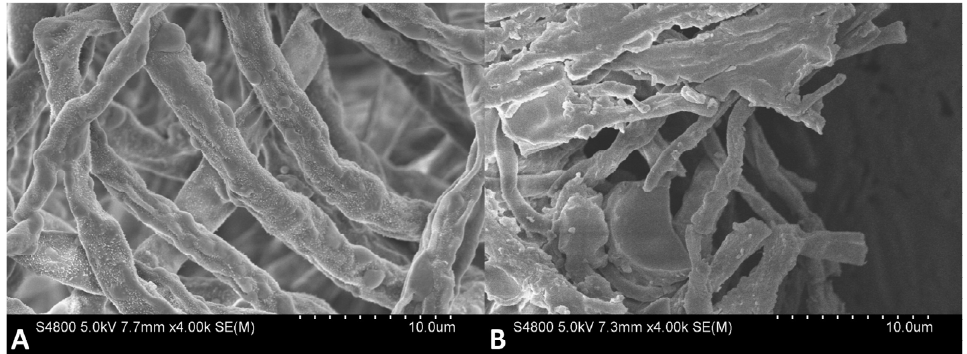
Figure 7. SEM images of V. mali mycelial morphology after 6-methylcoumarin treatment: ( A ) Un- treated hyphae (normal control) and ( B ) V. mali treated with 105 mg/L 6 ‐ MCM.